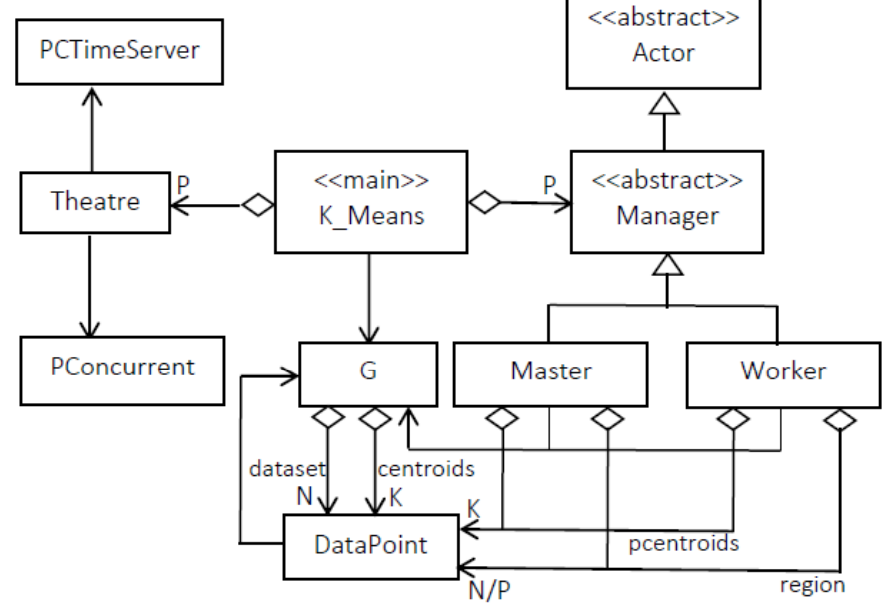
Figure 5. Supporting classes for Parallel K-Means based on Theatre.